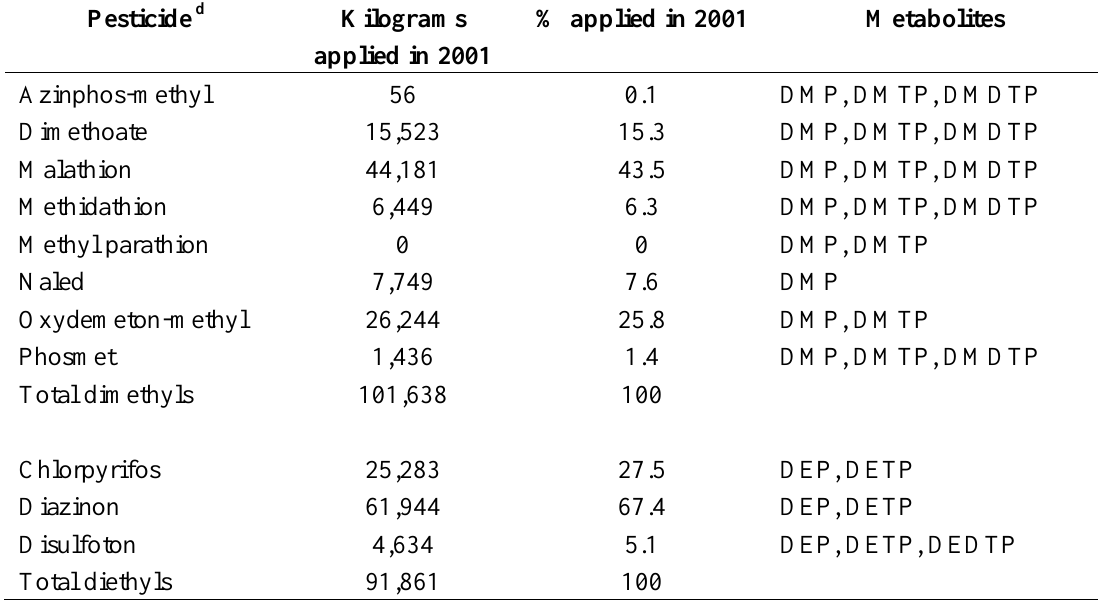
Table S1. OP pesticide usage in the Salinas Valley a,b,c and associated urinary dialkyl phosphate